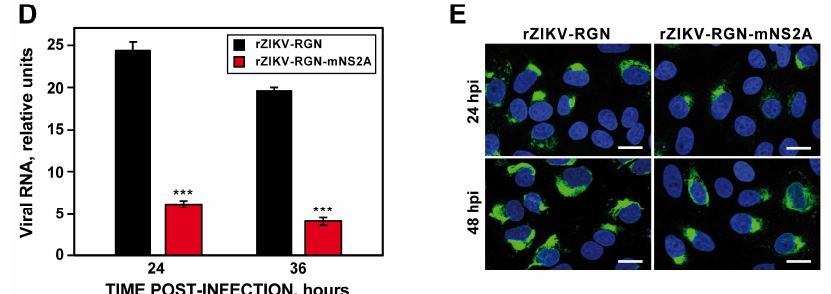
Figure 5. Rescue and growth properties of rZIKV-RGN-mNS2A in Vero cells. ( A ) Virus rescue. Vero cells at 90% of confluence (6-well plate format; triplicates) were transiently transfected with 4 µg/well of the infectious clones pBAC-ZIKV-RGN or pBAC-ZIKV-RGN-mNS2A, and at the indicated times post-transfection, virus titers in tissue culture supernatants were determined by plaque assay. Error bars represent standard deviations of the means from three experiments. ( B ) Plaque morphology. Vero cells at 90% confluence (6-well plate format) were infected with 25 PFU of rZIKV-RGN or rZIKV-RGN-mNS2A and at four days post-infection the viral plaques were visualized by immunostaining using the pan-flavivirus E protein mAb 4G2. ( C ) Growth kinetics. Vero cells at 90% confluence (24-well plate format; triplicates) were infected with rZIKV-RGN or rZIKV-RGN-mNS2A at high (2 PFU/cell, left) or low (0.05 PFU/cell, right) MOI, and at the indicated hpi virus titers were determined by plaque assay. Error bars represent standard deviations of the mean from three experiments. ( D ) Analysis of viral RNA synthesis. Vero cells at 90% confluence (12-well plate format; triplicates) were infected (MOI of 0.5 PFU/cell) with rZIKV-RGN or rZIKV-RGN-mNS2A and at the indicated hpi, viral RNA levels were quantified by RT-qPCR. Error bars represent standard deviations of the mean from three experiments. ( E ) Analysis of viral E protein expression. Vero cells were infected (MOI of 0.5 PFU/cell) with rZIKV-RGN or rZIKV-RGN-mNS2A and at the indicated hpi, viral E protein expression was analyzed by IFA using the pan-flavivirus E protein mAb 4G2. Bars, 20 µ m. Asterisks in panels A, C, and D indicate that the differences between rZIKV-RGN and rZIKV-RGN-mNS2A are statistically significant when data are compared using the unpaired t test (***, P <